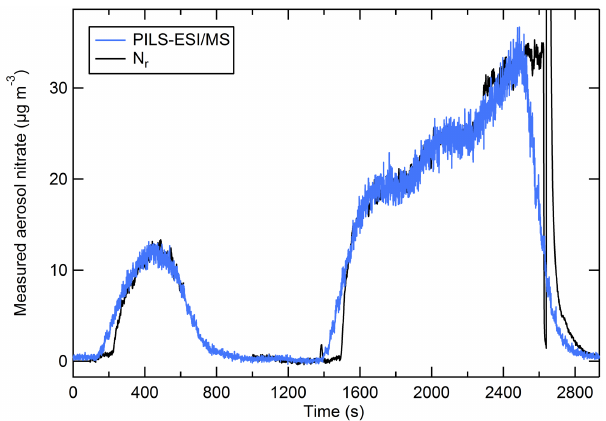
Figure 9. Scatter plots of PILS–ESI/MS measured versus equiva- lent anion mass measured as N r for salts NaNO 3 (blue), NH 4 NO 3 (gold), ( NH 4 ) 2 SO 4 (red), and NH 4 Cl (magenta). The data are 60s averages and only include times when the atomized aerosol output was relatively constant (i.e., not when concentrations were rising or falling). The slope (1 σ ) and R 2 are